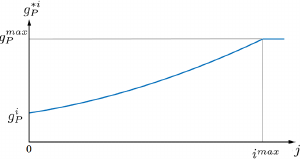
Figure 1. Sample weight function according to Eq. (4), assuming constant g i n during the